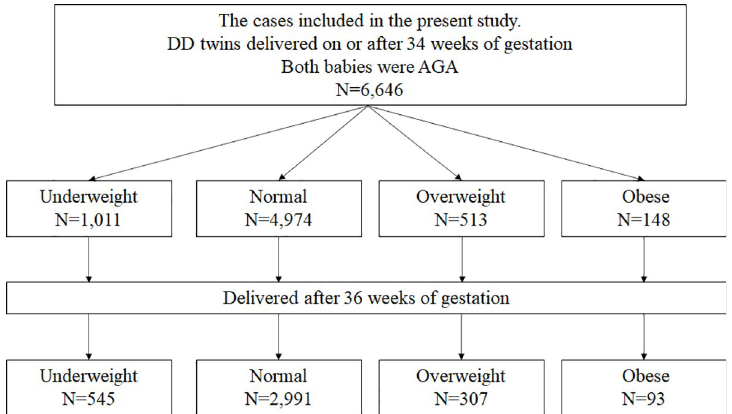
Fig 2. Flow chart of the cases included in the present study. Underweight (BMI < 18.5 kg/m 2 ), normal weight (18.5 kg/m 2 � BMI < 25.0 kg/m 2 ), overweight (25.0 kg/m 2 � BMI < 30.0 kg/m 2 , obese (BMI � 30.0 kg/m 2 ). The number of cases refers to the number of women who delivered the twins. BMI: Body mass index.